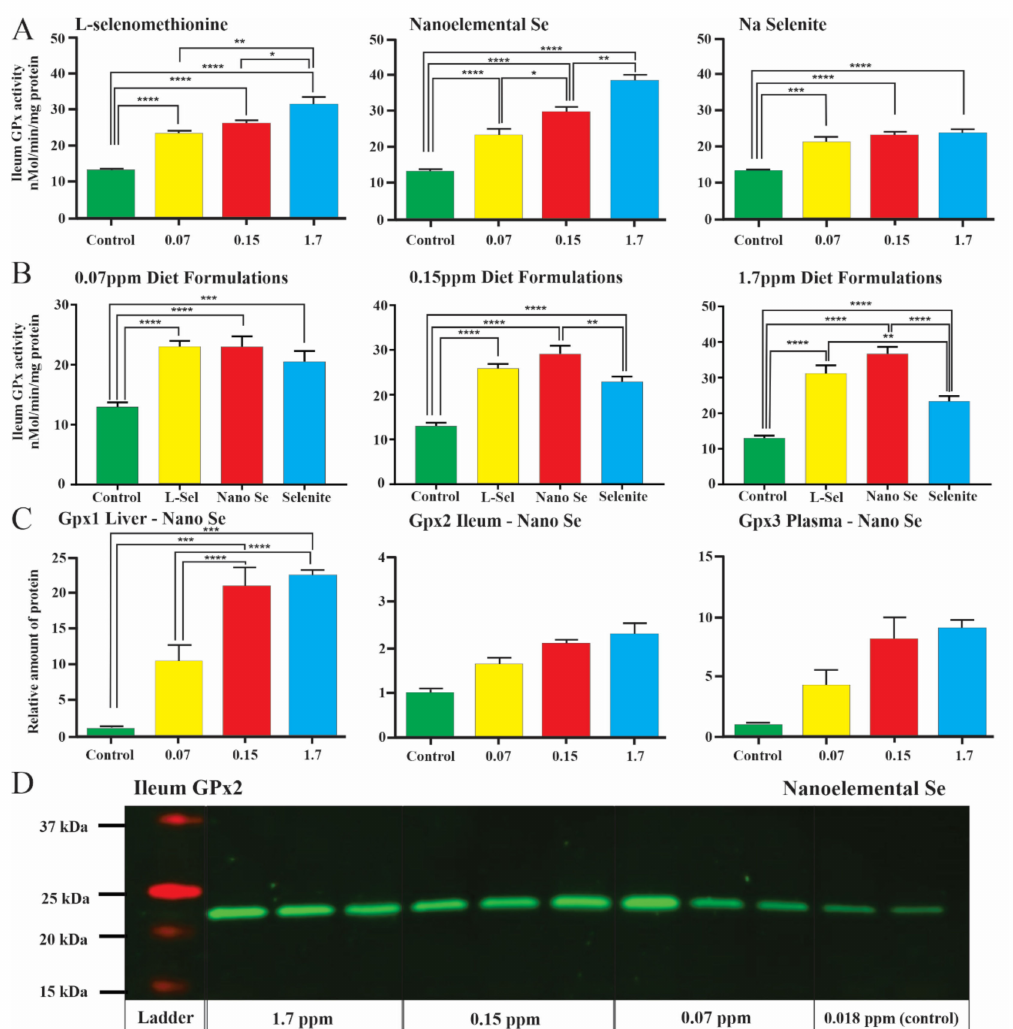
Figure 3. ( A ): glutathione peroxidase (GPx) activity in the ileum after feeding mice with diets containing Se derived from different formulations. ( B ): Comparison of GPx activity in ileum between different Se formulations at a similar dietary level. ( C ): Relative amounts of GPx protein in the liver, ileum and plasma after feeding mice with nanoelemental Se for 5 weeks, as measured by fluorescence intensity, relative to control diets. ( D ): Representative fluorescent immunoblot of GPx2 protein in ileum tissue from mice fed a nanoelemental Se supplemented diet at 0.3, 0.15, 1.7 ppm and control diet (0.018 ppm) for 5 weeks, each lane is an individual protein sample. The dominant GPx form in each tissue was measured. Please note different vertical scales. One-way ANOVA was carried out with Tukey’s multiple comparisons between groups. Data is presented as mean ± SEM. p < 0.05 *, p < 0.01 **, p < 0.001 ***, p < 0.0001